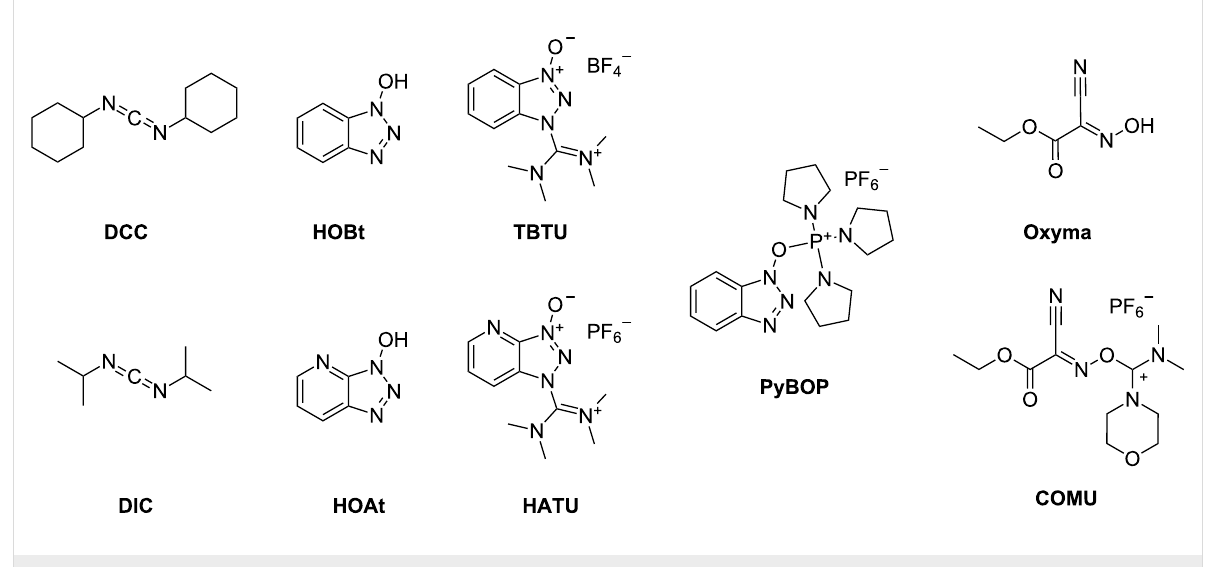
Figure 3: Selected coupling reagents for